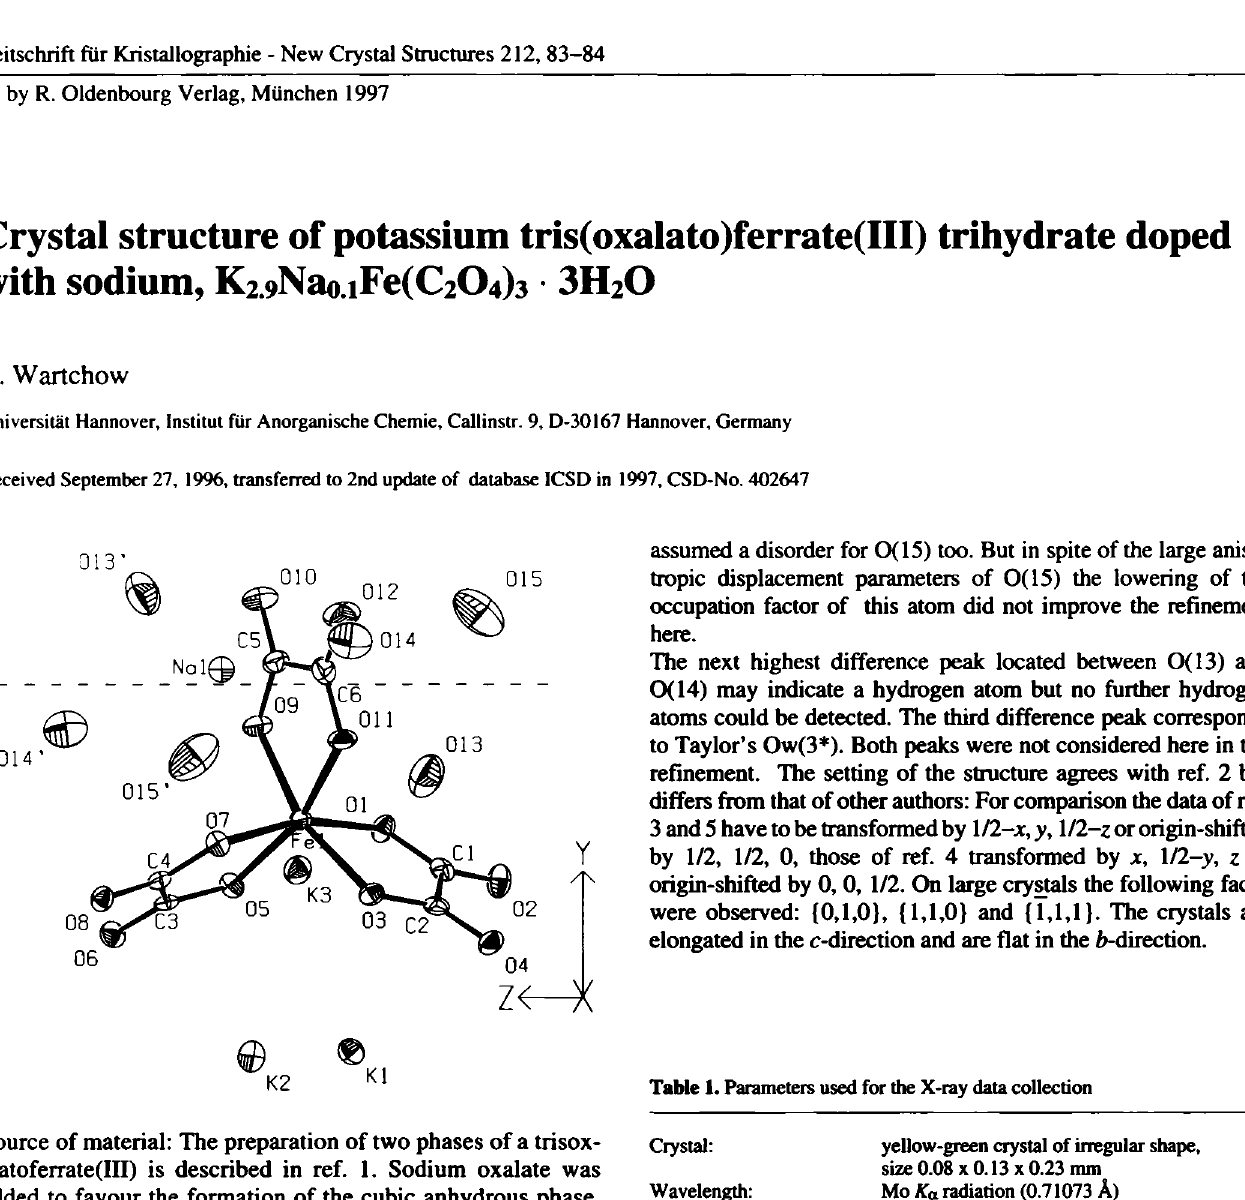
Source of material: The preparation of two phases of a trisox- alatoferrate(III) is described in ref. 1. Sodium oxalate was added to favour the formation of the cubic anhydrous phase.